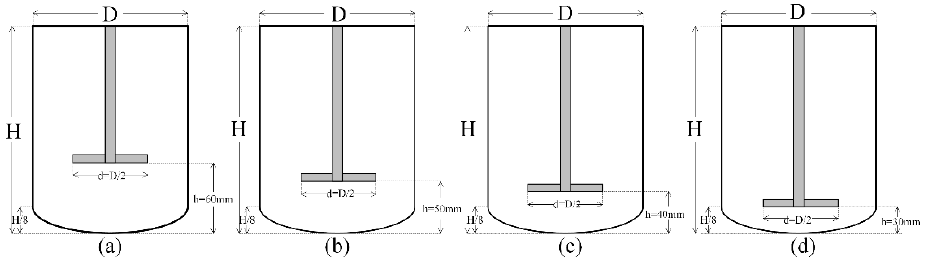
Figure 3. Configurations of the stirred tank with the height of blades is ( a ) 30 mm. ( b ) 40 mm. ( c ) 50 mm. ( d ) 60 mm.